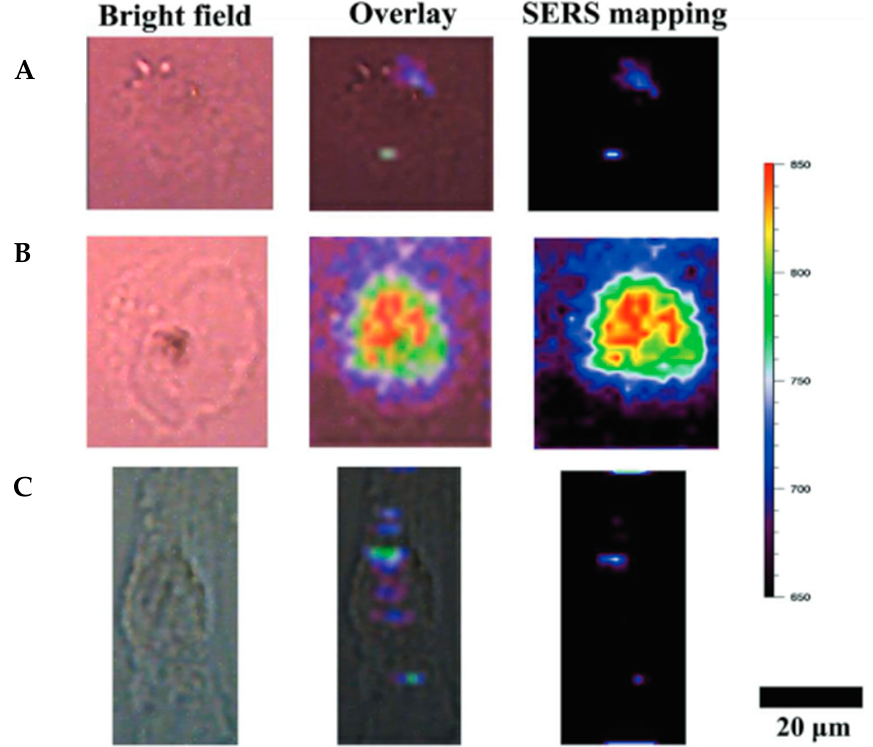
Figure 11. Confocal Raman images of MCF-7 breast cancer cells stained with ( A ) NIP@AuNR and ( B ) MIP@AuNR against EGFR. ( C ) Wpmy-1 human normal prostate stromal cells stained with MIP@AuNR. Reproduced with permission from [94] © 2021 John Wiley and Sons .